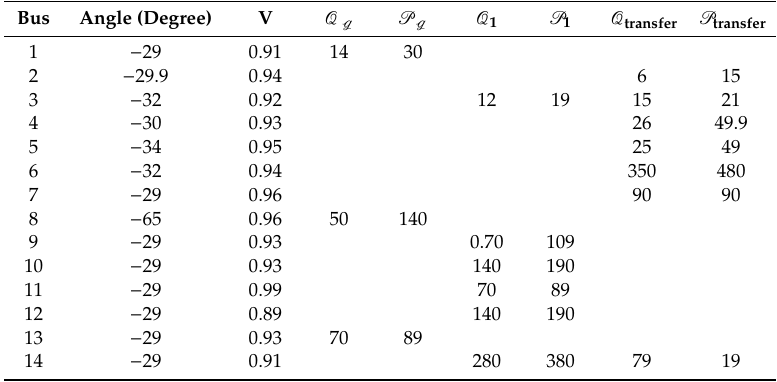
Table 7. Result of loads at minimum demand.